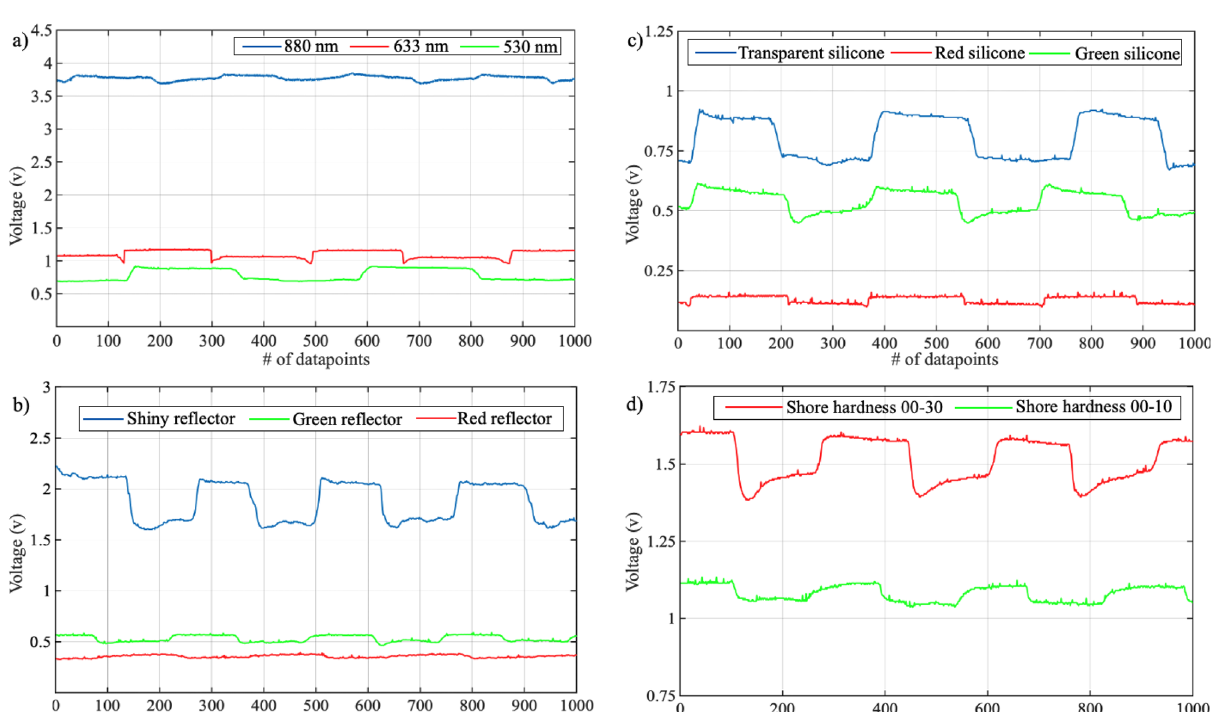
Figure 2. Exemplar graphs of the experiments conducted. ( a ), presents a comparison between the acquired data using three different light wavelengths: 530 nm, 633 nm, and 880 nm. ( b ), presents a comparison between the acquired data using three different flexible reflective surfaces: green, red, and shiny. ( c ), presents a comparison between the acquired data using three different colors for the silicone medium: green, red, and transparent. Finally, ( d ), presents a comparison between the acquired data using two different stiffness levels for the silicone